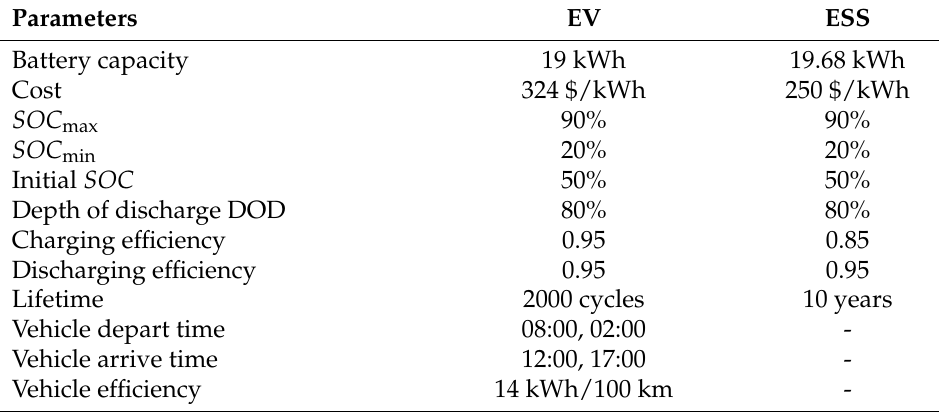
Figure 5. ( a ) Hourly home energy consumption; ( b ) EV connection time. Table 3. Parameters associated with the ESS and EV.